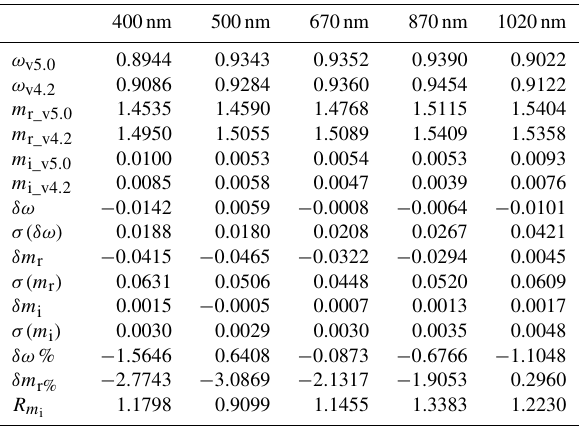
Meanings of all symbols are the same as in Table